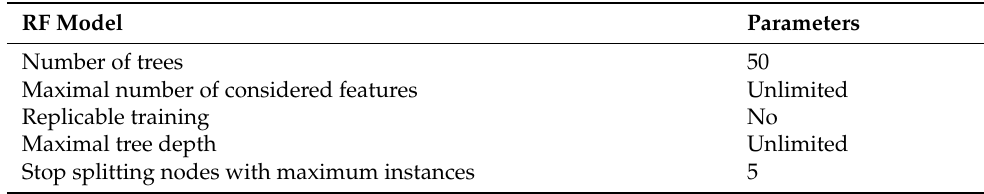
Table 2. The parameters of RF algorithm.